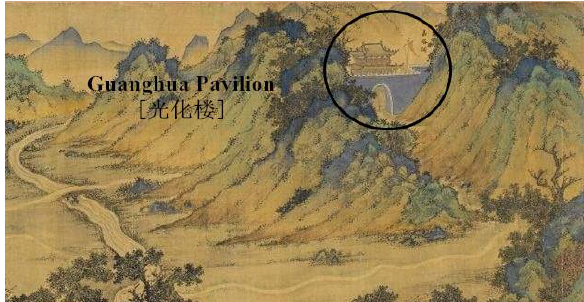
Figure 2. the first volume of Menggu Landscape Map [ 蒙古山 水地图 ]-- Guanghua Pavilion [ 光化楼 ] Ancient pavilions can’t be recovered when they are